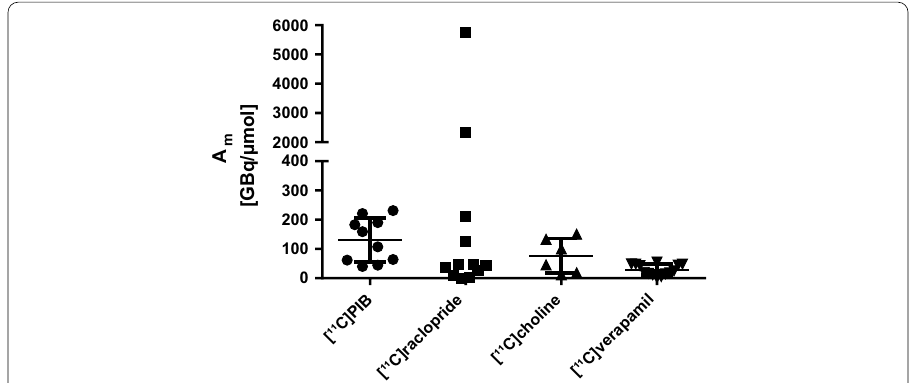
Fig. 3 Distribution of A m as described in literature for the clinically applied PET-tracers [ 11 C]PIB, [ 11 C] raclopride, [ 11 C]choline and [ 11 C]verapamil produced at different